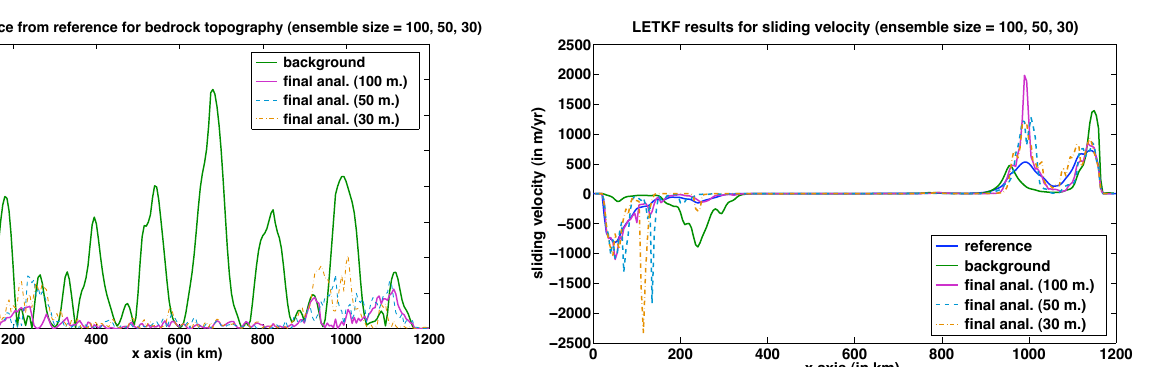
Fig. 18. Sliding component U slid of the surface velocity after 20 years of the LETKF with inflation. The mean of the final analysis ensemble is compared to the background (green) and the reference (blue), for various ensemble sizes: 100 members (purple), 50 mem- bers (cyan), and 30 members (orange). Localisation and inflation parameters are described in Table 3. See also Fig. 19 for detailed results.